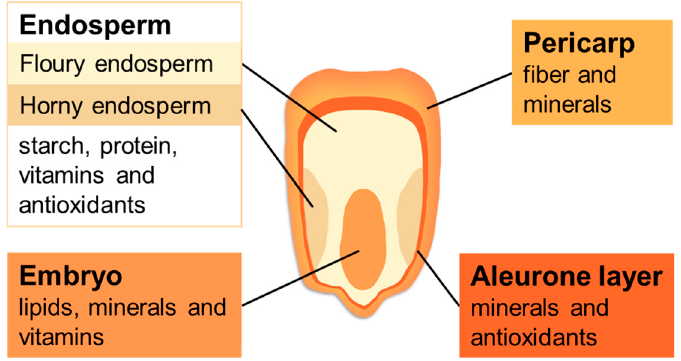
Figure 1. Structure and nutrient distribution of maize kernels.